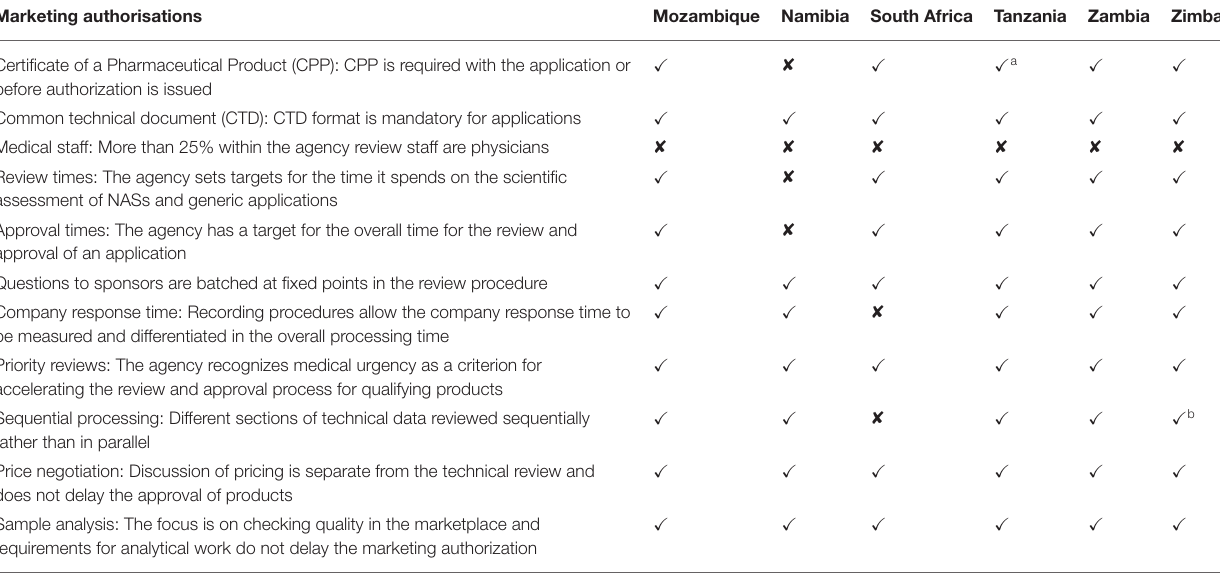
TABLE 5 | Summary comparison of key features of the regulatory systems for